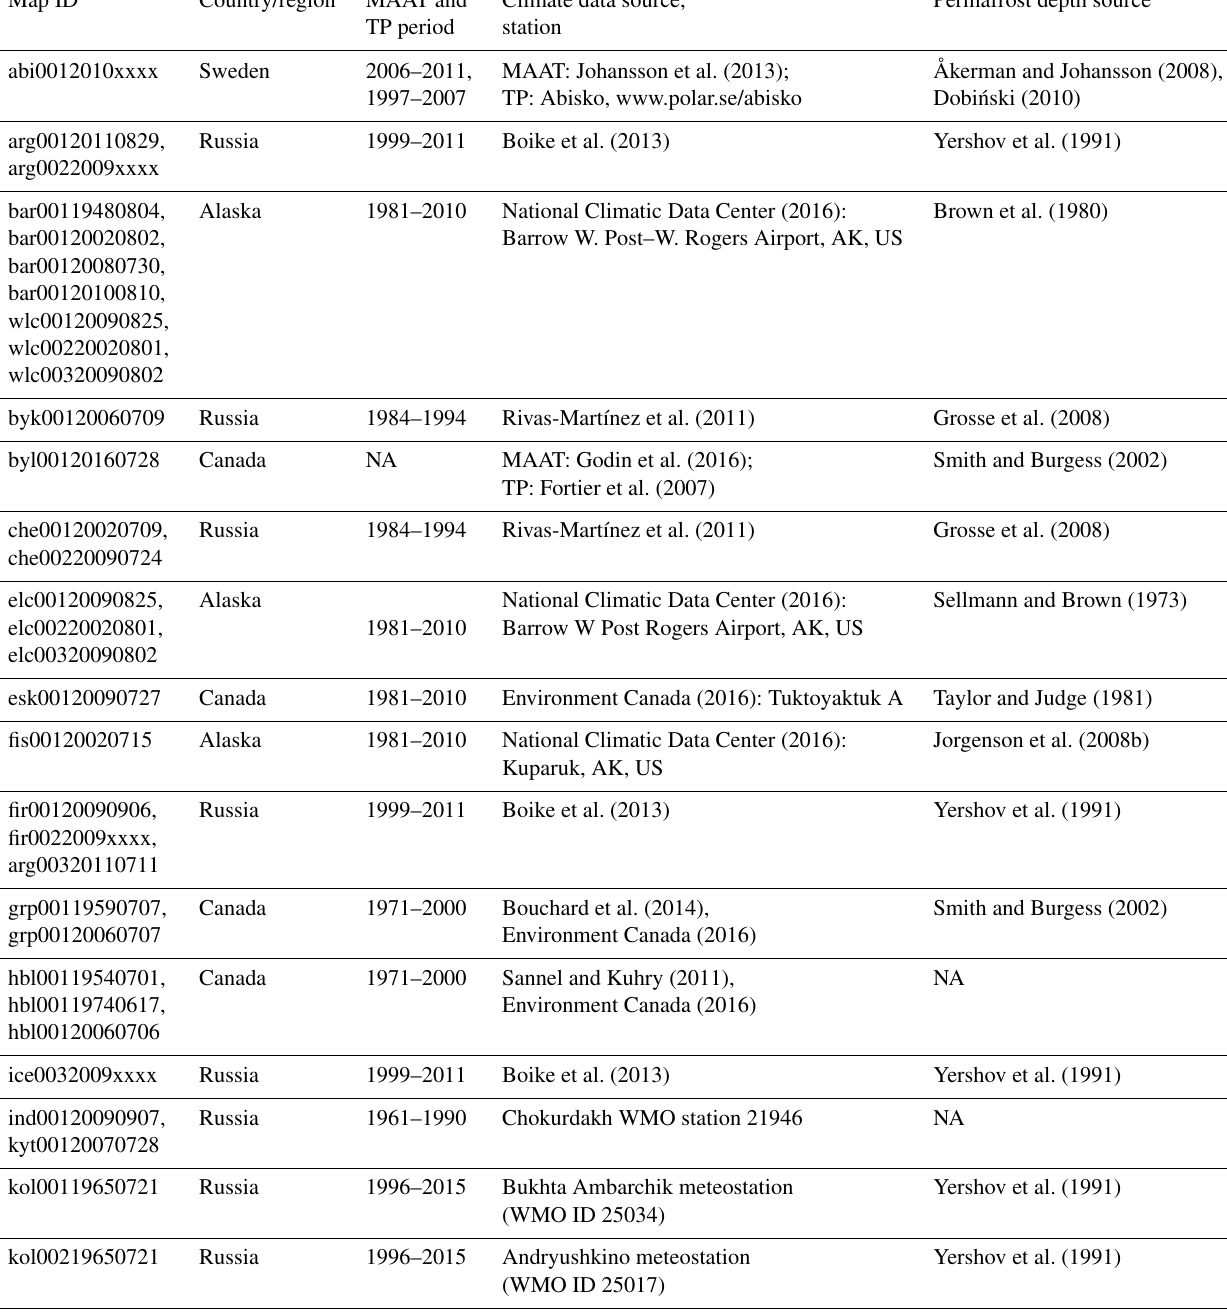
Table C1. Metadata and references for climate data and permafrost depth. TP: total